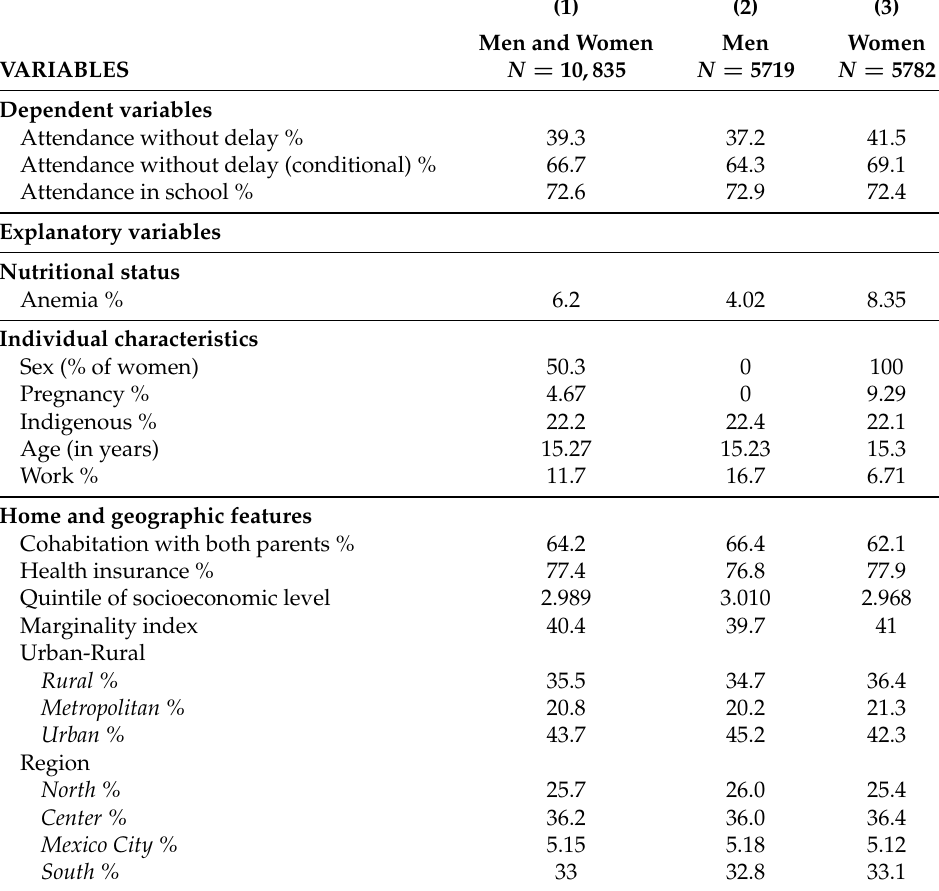
Table A1. Descriptive statistics of the sample (mean value of the